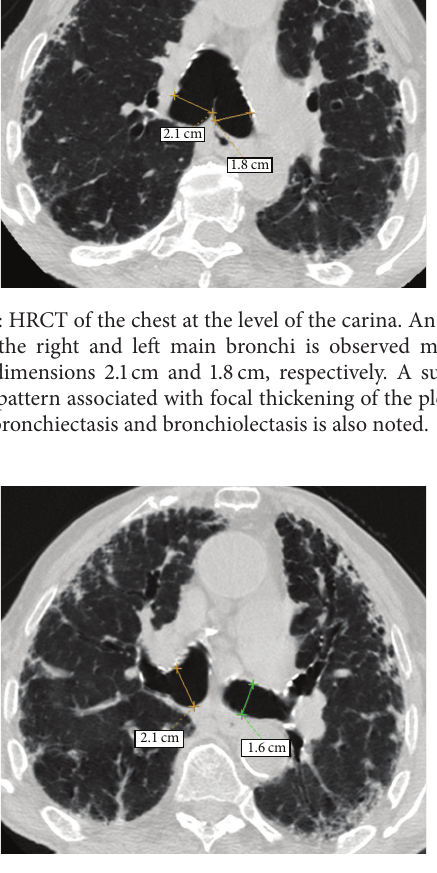
Figure 5: HRCT of the chest at level below carina shows dilated right and left main bronchi and undulating wall of left main bronchus, indicating bronchial diverticulosis. A subpleural reticular pattern associated with focal thickening of the pleura and traction bronchiectasis and bronchiolectasis is also noted.